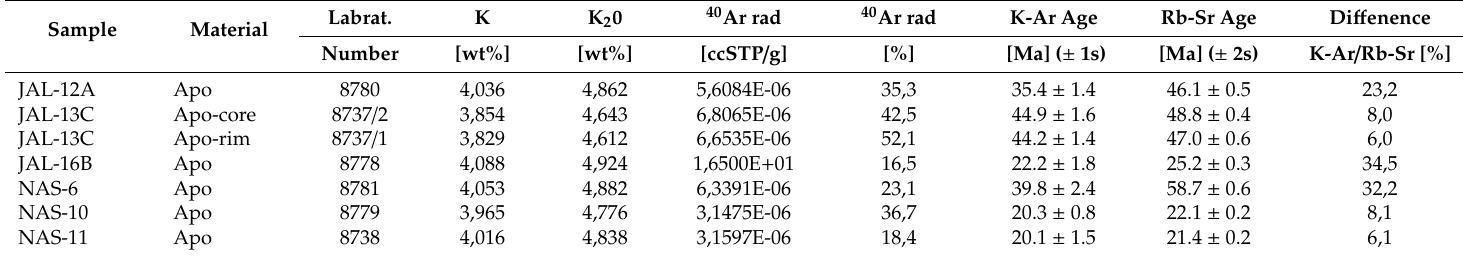
Table 10. K-Ar isotopic compositions of apophyllite (Apo) from the DVP (India) from Savda / Jalgaon and Nashik. In comparison, the corresponding Rb-Sr ages are also